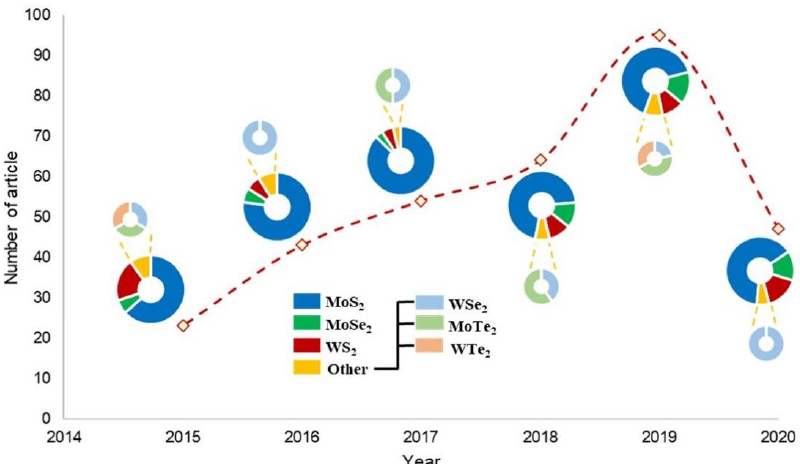
Figure 1. The number of research articles that applied transition metal dichalcogenides (TMDCs) in gas adsorption application between the year 2015 to April 2020, where pie charts represent the utilization percentage of various types of TMDC. Queried from Scopus Database [48]. Copyright